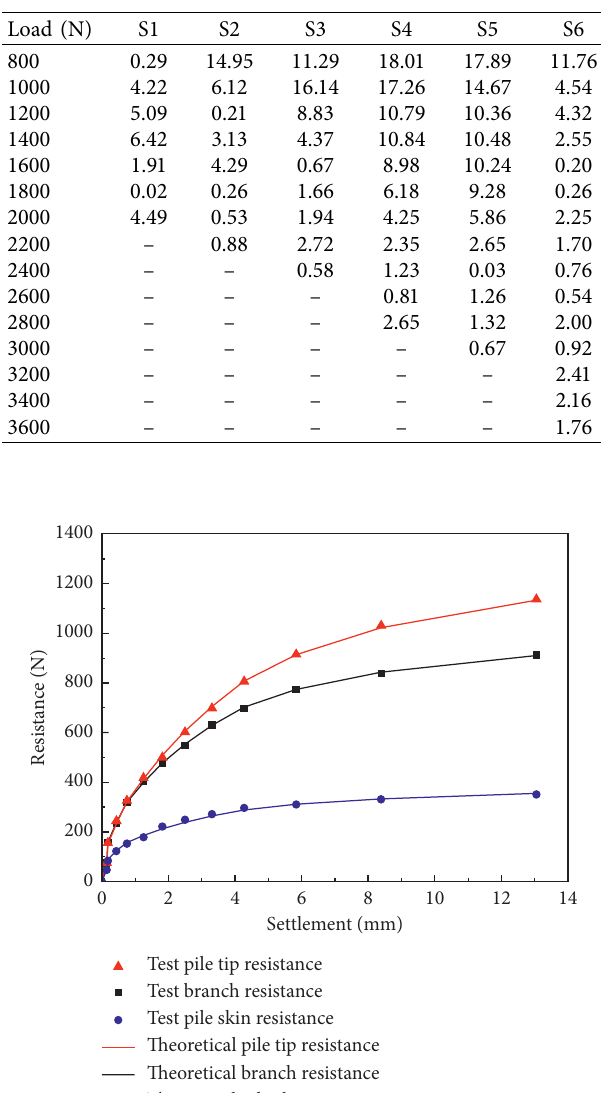
Figure 4: Bearing capacity composition analysis of S2